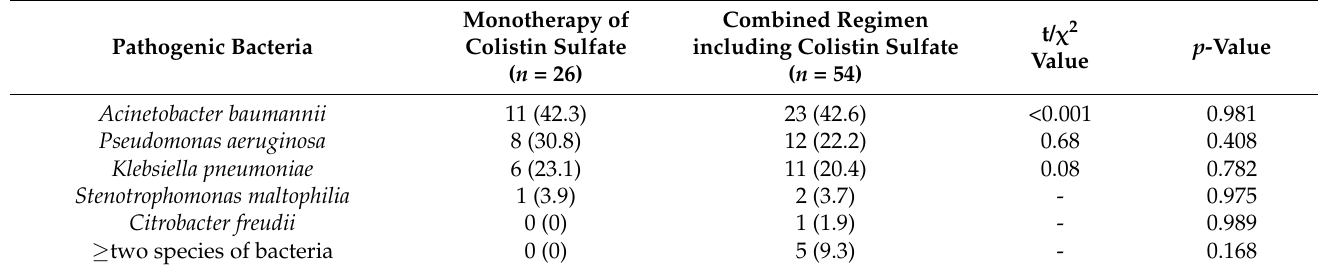
Table 2. Comparison of pathogenic bacteria between monotherapy and combination therapy